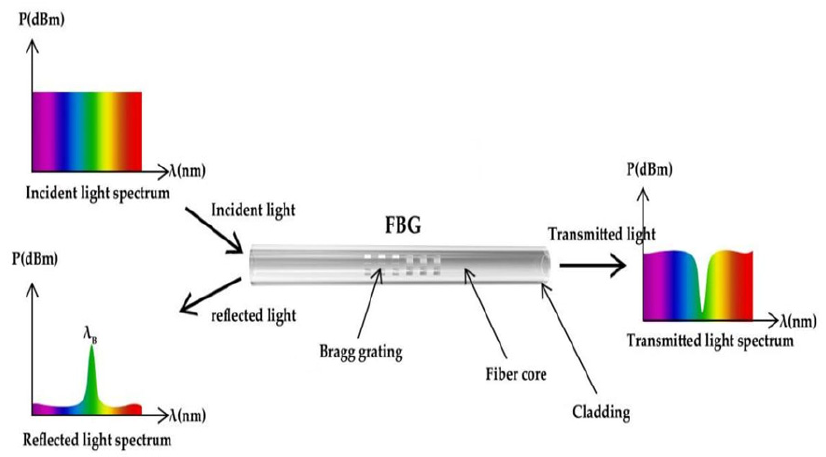
Figure 5. FBG reflection principle.